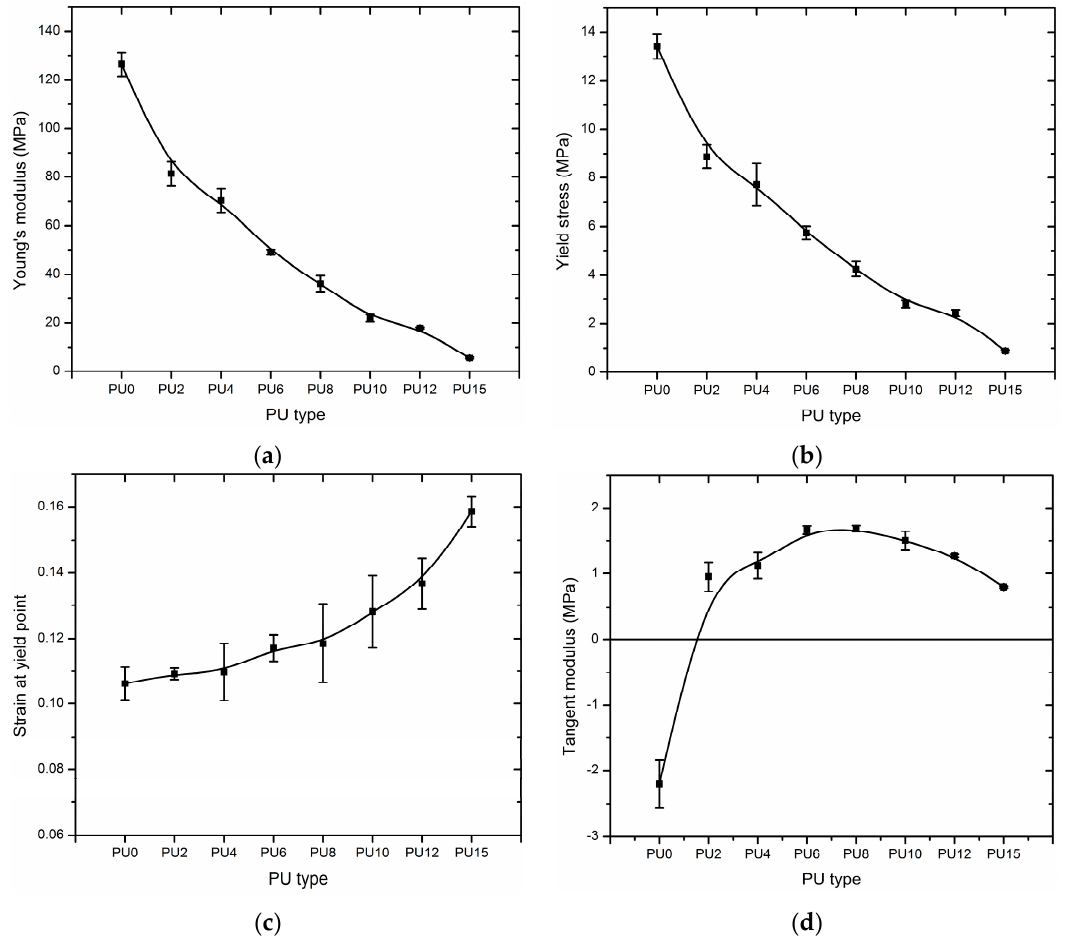
Figure 7. Comparison of tensile properties of the PUs, ( a ) Young’s modulus; ( b ) yield stress; ( c ) strain at yield point; ( d ) tangent modulus. (PU0–PU15 are types of PU and PU6—PU which contained 6% PEG).